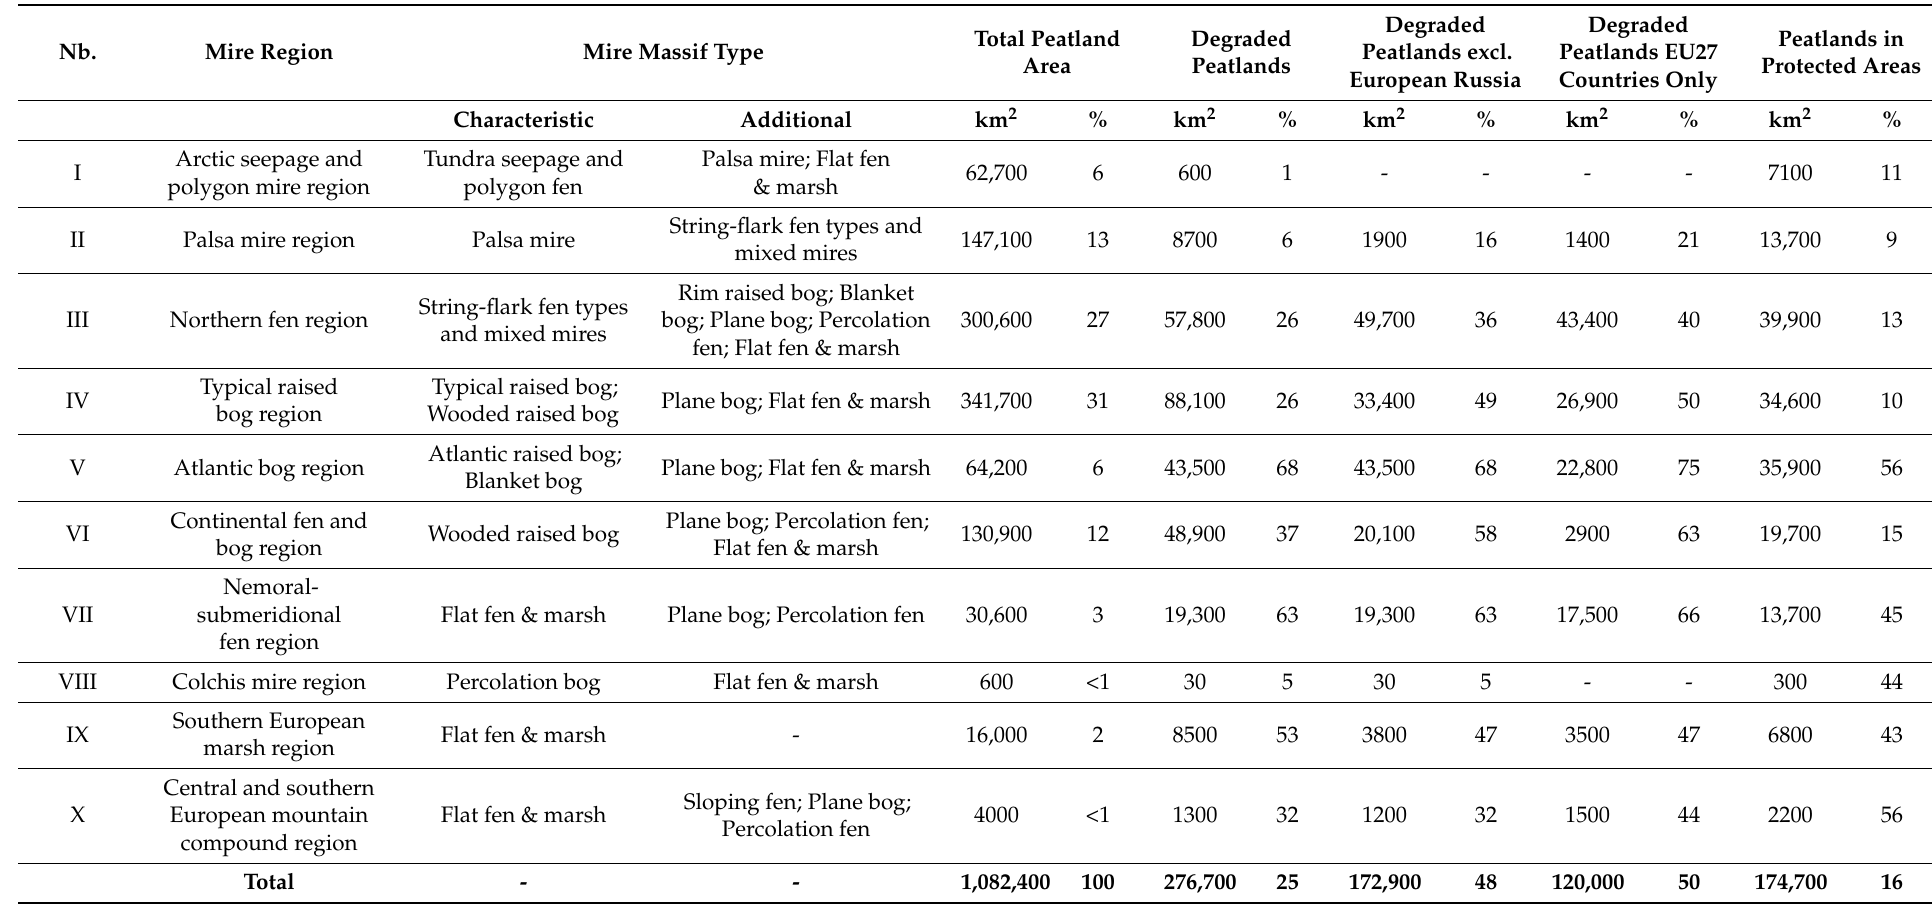
Table 1. Mire regions with characteristic and additional mire massif types (from [27]) and key properties of their peatlands (total area, degraded area, protected area; in km 2 and %). As the degree of degradation differs strongly between European Russia and the rest of the continent, figures are also presented excluding European Russia. The total peatland area in Europe excluding European Russia is 363,100 km 2 ; that in EU27 countries is 241,000 km 2 .